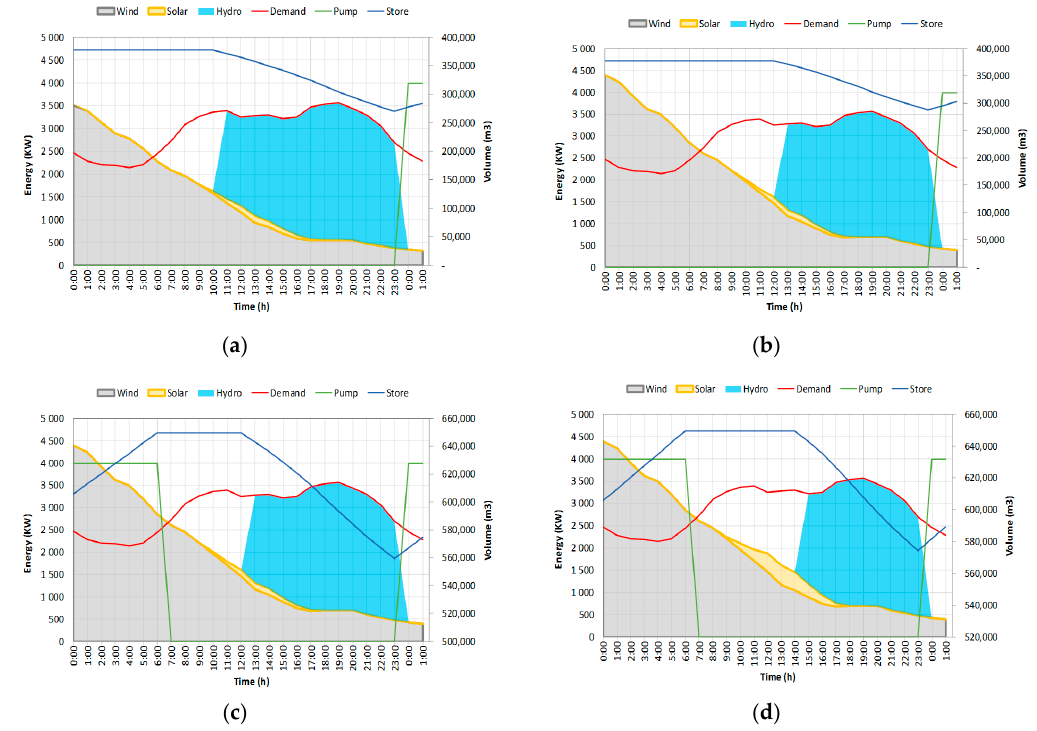
Figure 15. Energy contribution on a winter day: ( a ) scenario 1; ( b ) scenario 2; ( c ) scenario 3; ( d ) Figure15. Energycontributiononawinterday: ( a )scenario1; ( b )scenario2; ( c )scenario3; ( d scenario 4.